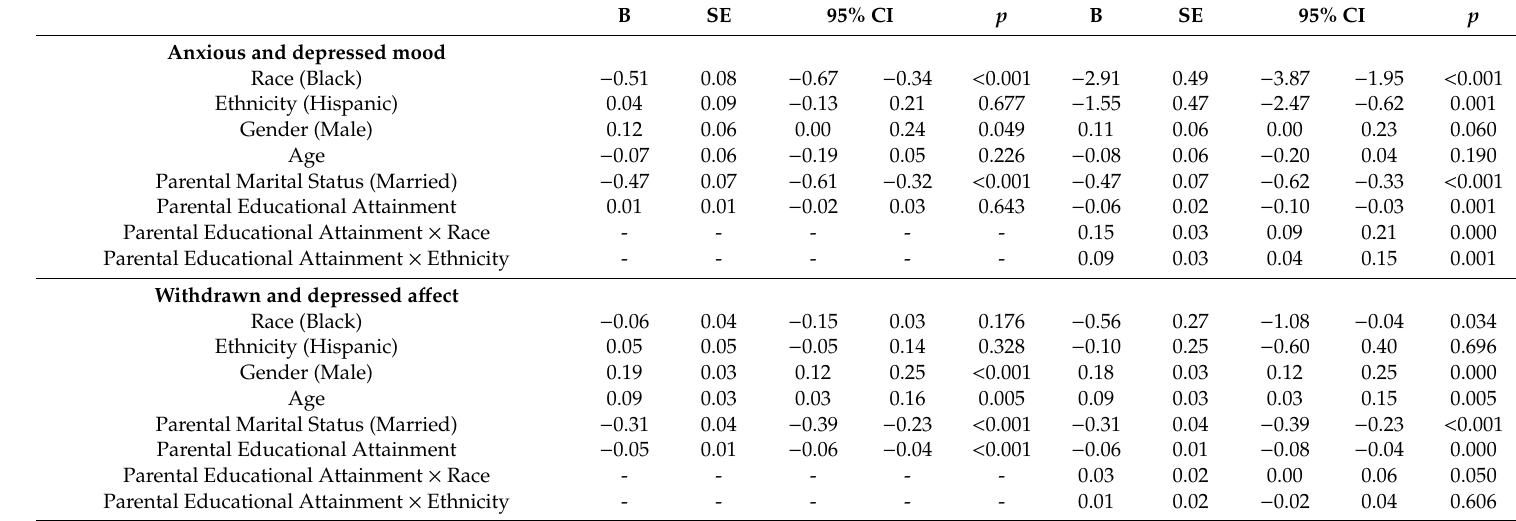
Table 4. Summary of linear regressions